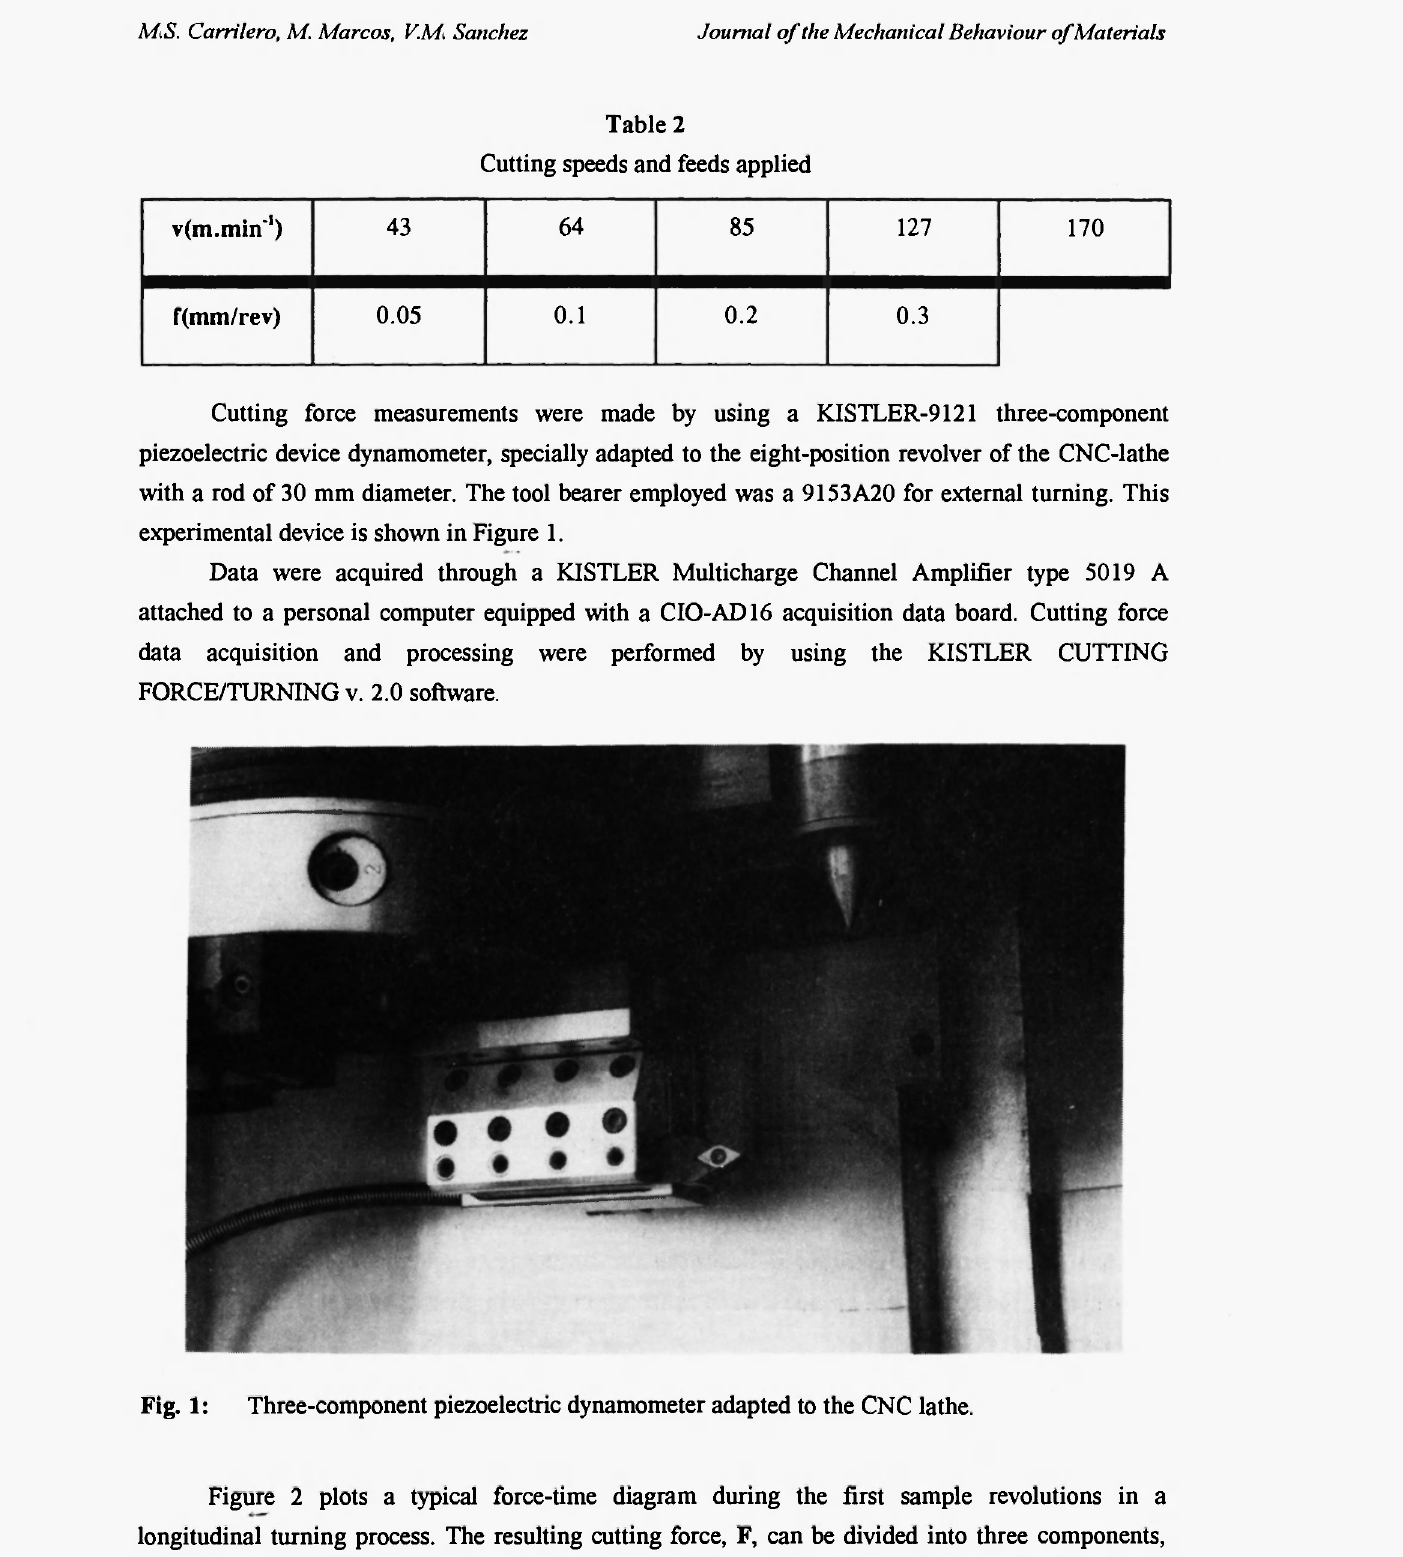
Cutting speeds and feeds applied